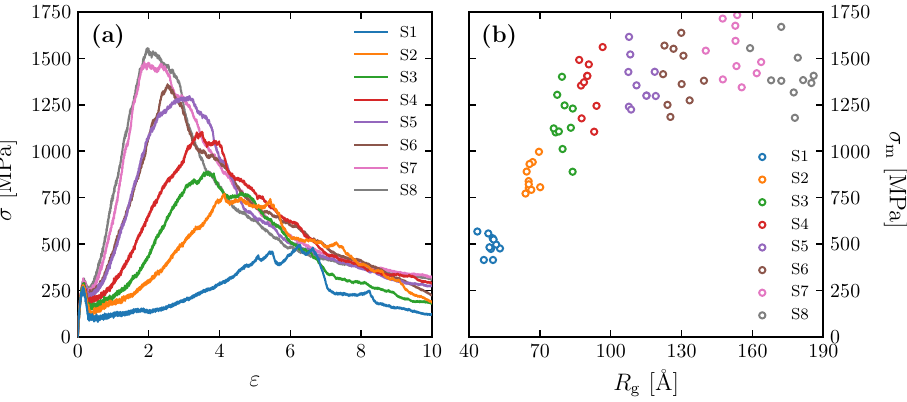
Figure 7. ( a ) Stress–strain curves for simulation cells of S1–S8; ( b ) σ m as a function of R g for M n = 32.8